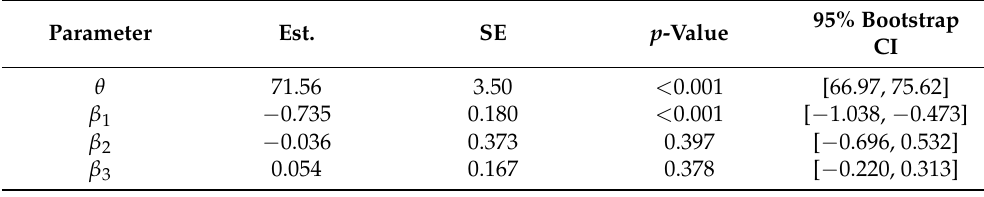
Table 4. The fitting results of colon cancer data.